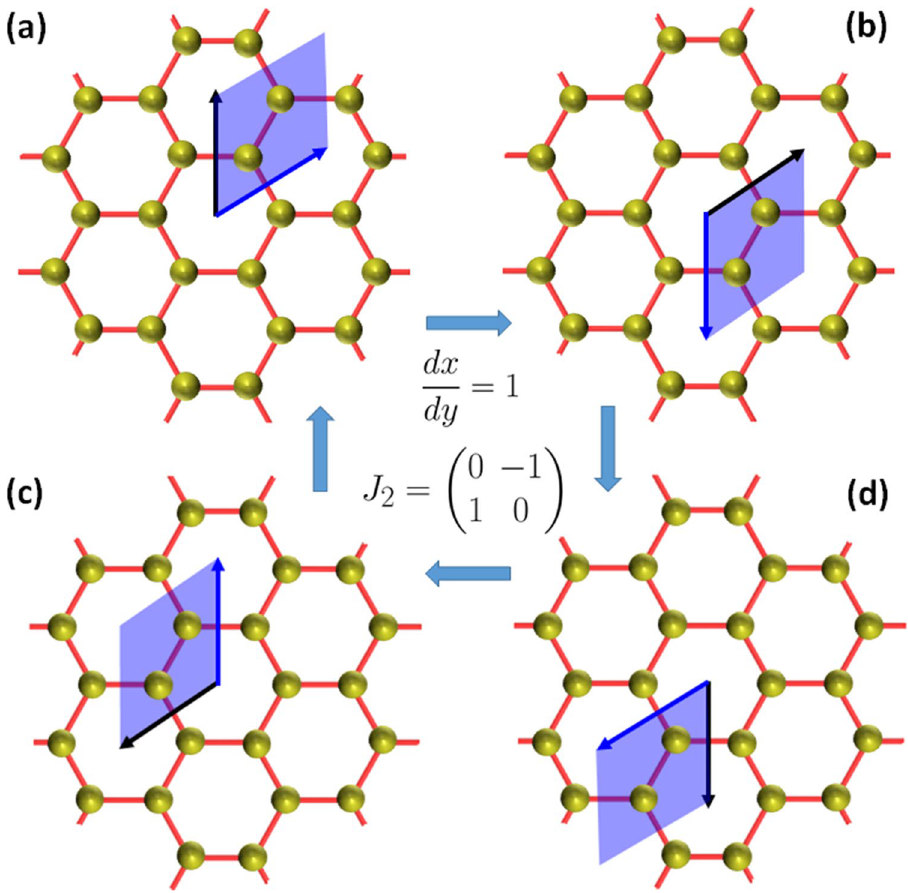
1 ) generated by J 2 SL 2 ( Z ) acting = ∈ 2 2 ×